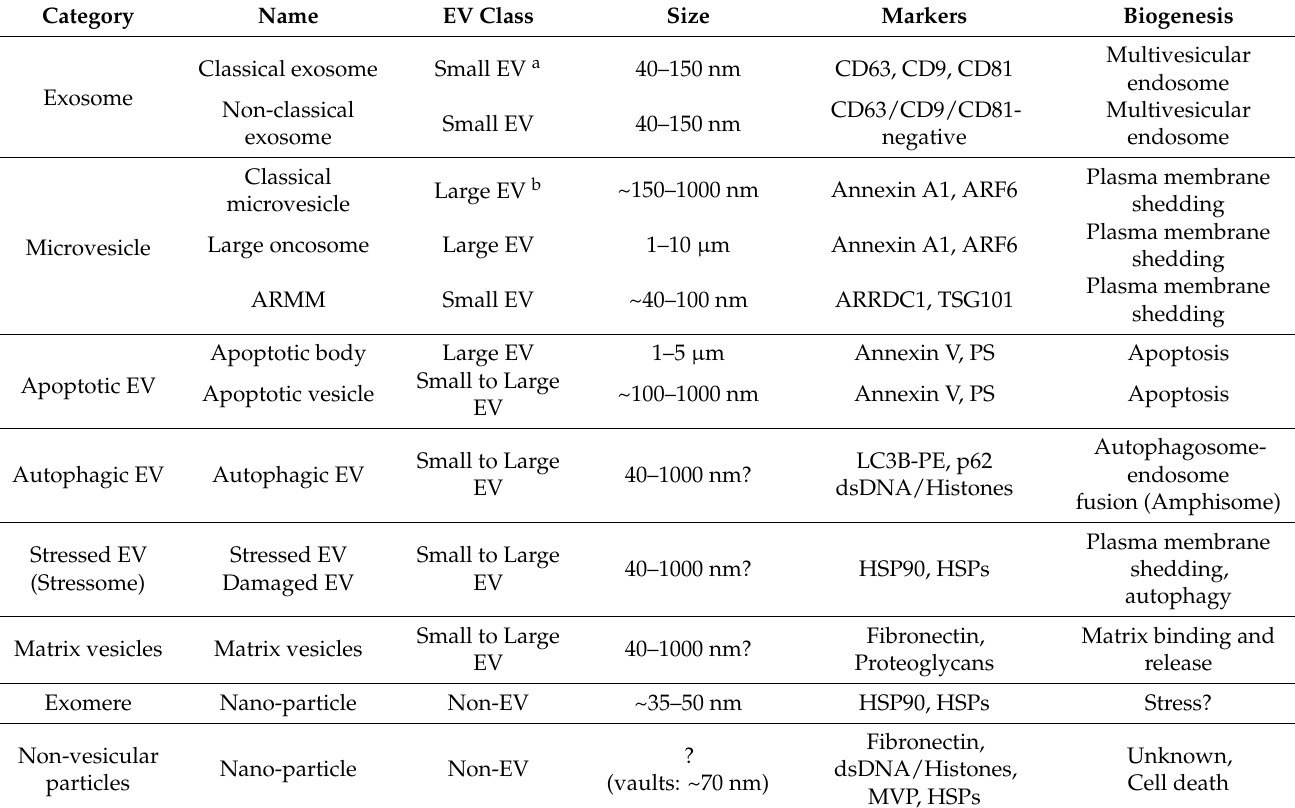
Table 1. Classification of extracellular